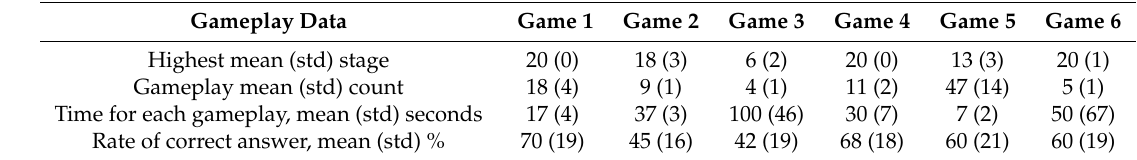
Table A2. Analysis of participants’ gameplay data.